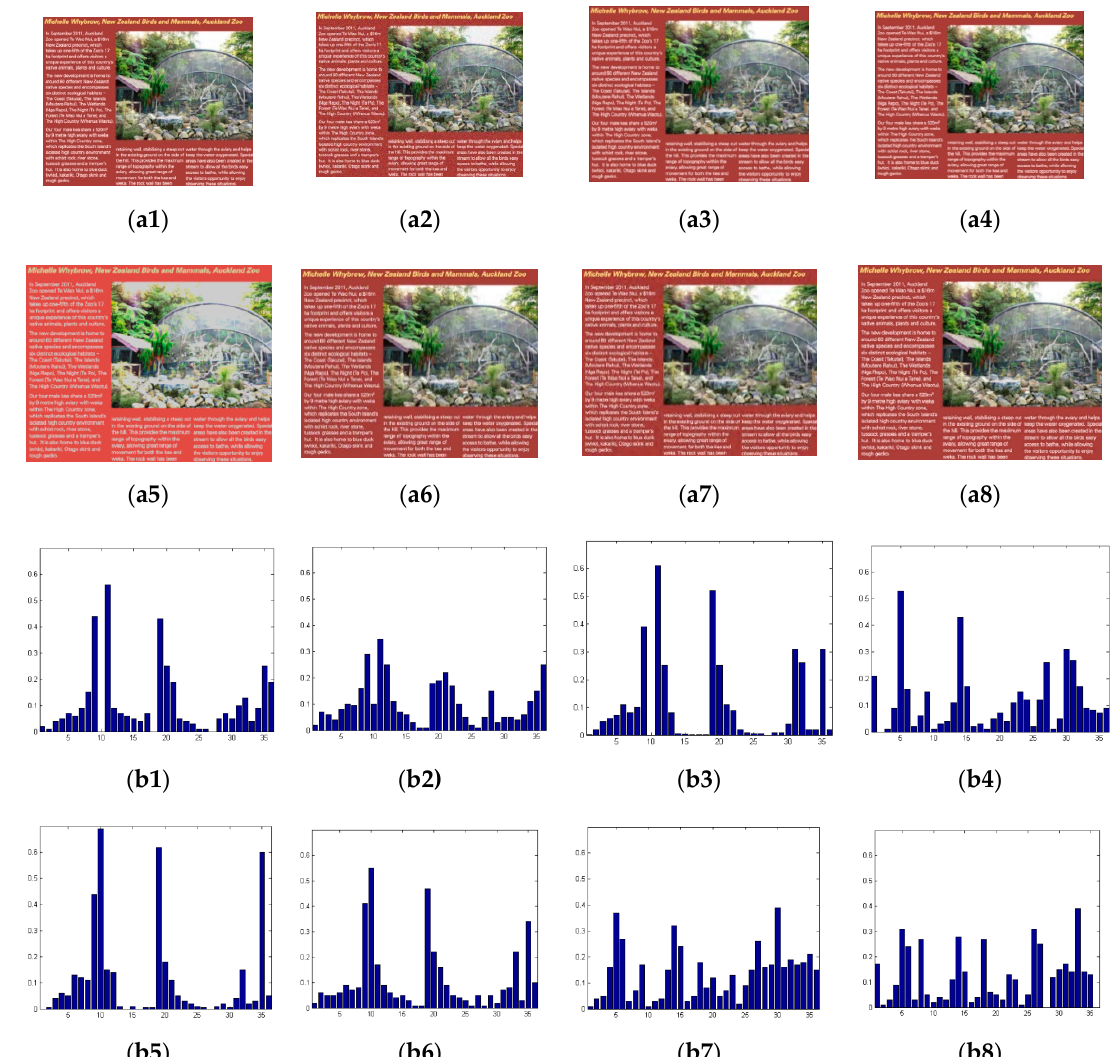
Figure 5. The examples of the IHOG features of textual regions; ( a1 ) is a reference SCI, ( a2 – a8 ) are distorted SCIs and distortion types of ( a2 – a8 ) are GN, GB, MB, CC, JPEG, JP2K and LSC, respectively; ( b1 – b8 ) are the histogram of orientated gradient (HOG) features of the first-order derivative of textual regions contained in the corresponding subgraphs ( a1 – a8 ).